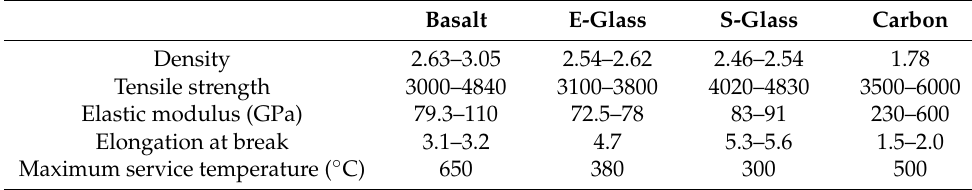
Table 1. Properties of basalt fibre with glass and carbon fibres [5,6].